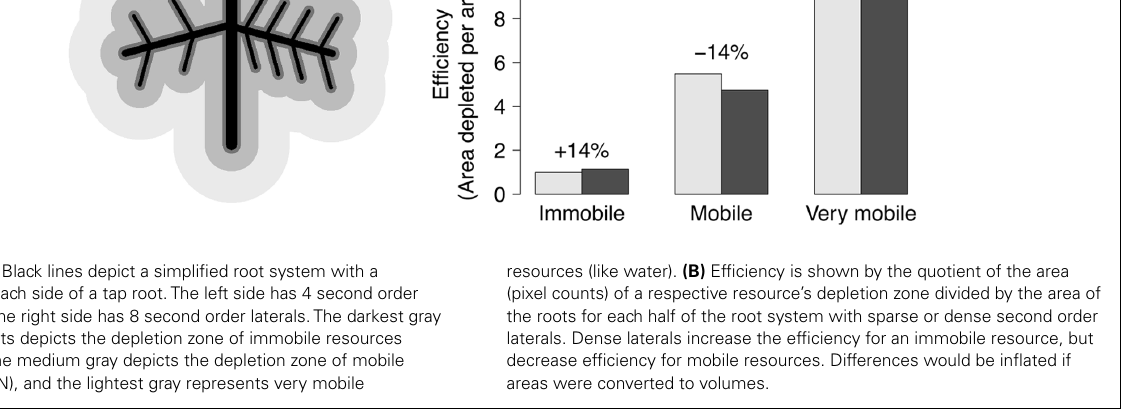
resources (like water). (B) Efficiency is shown by the quotient of the area (pixel counts) of a respective resource’s depletion zone divided by the area of the roots for each half of the root system with sparse or dense second order laterals. Dense laterals increase the efficiency for an immobile resource, but decrease efficiency for mobile resources. Differences would be inflated if areas were converted to